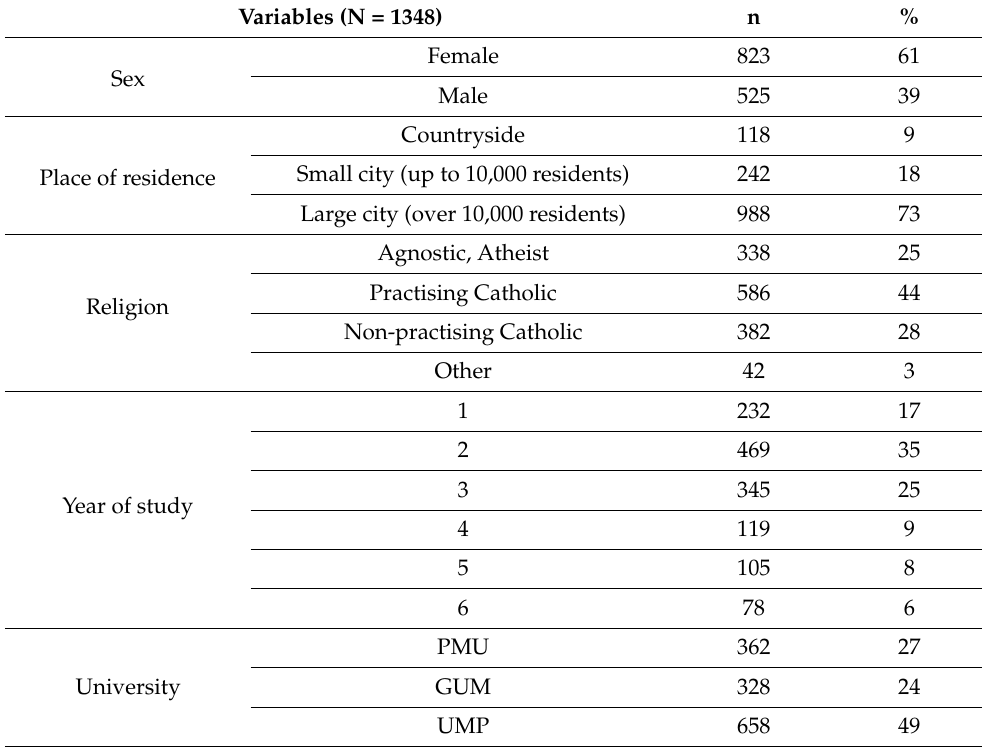
Table 1. Socioeconomic data of the